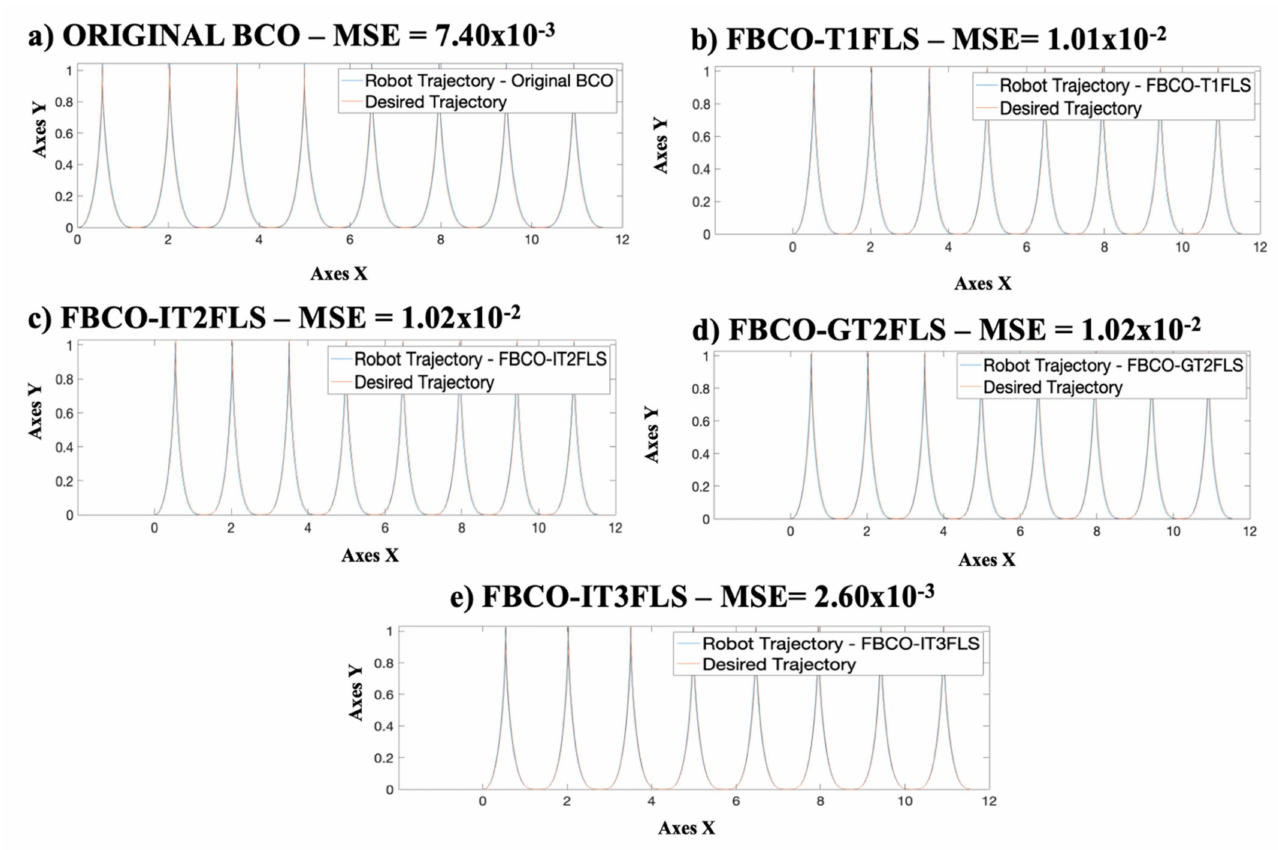
Figure 27. Behavior of the best trajectory for each method with perturbation. ( a ) Original BCO,